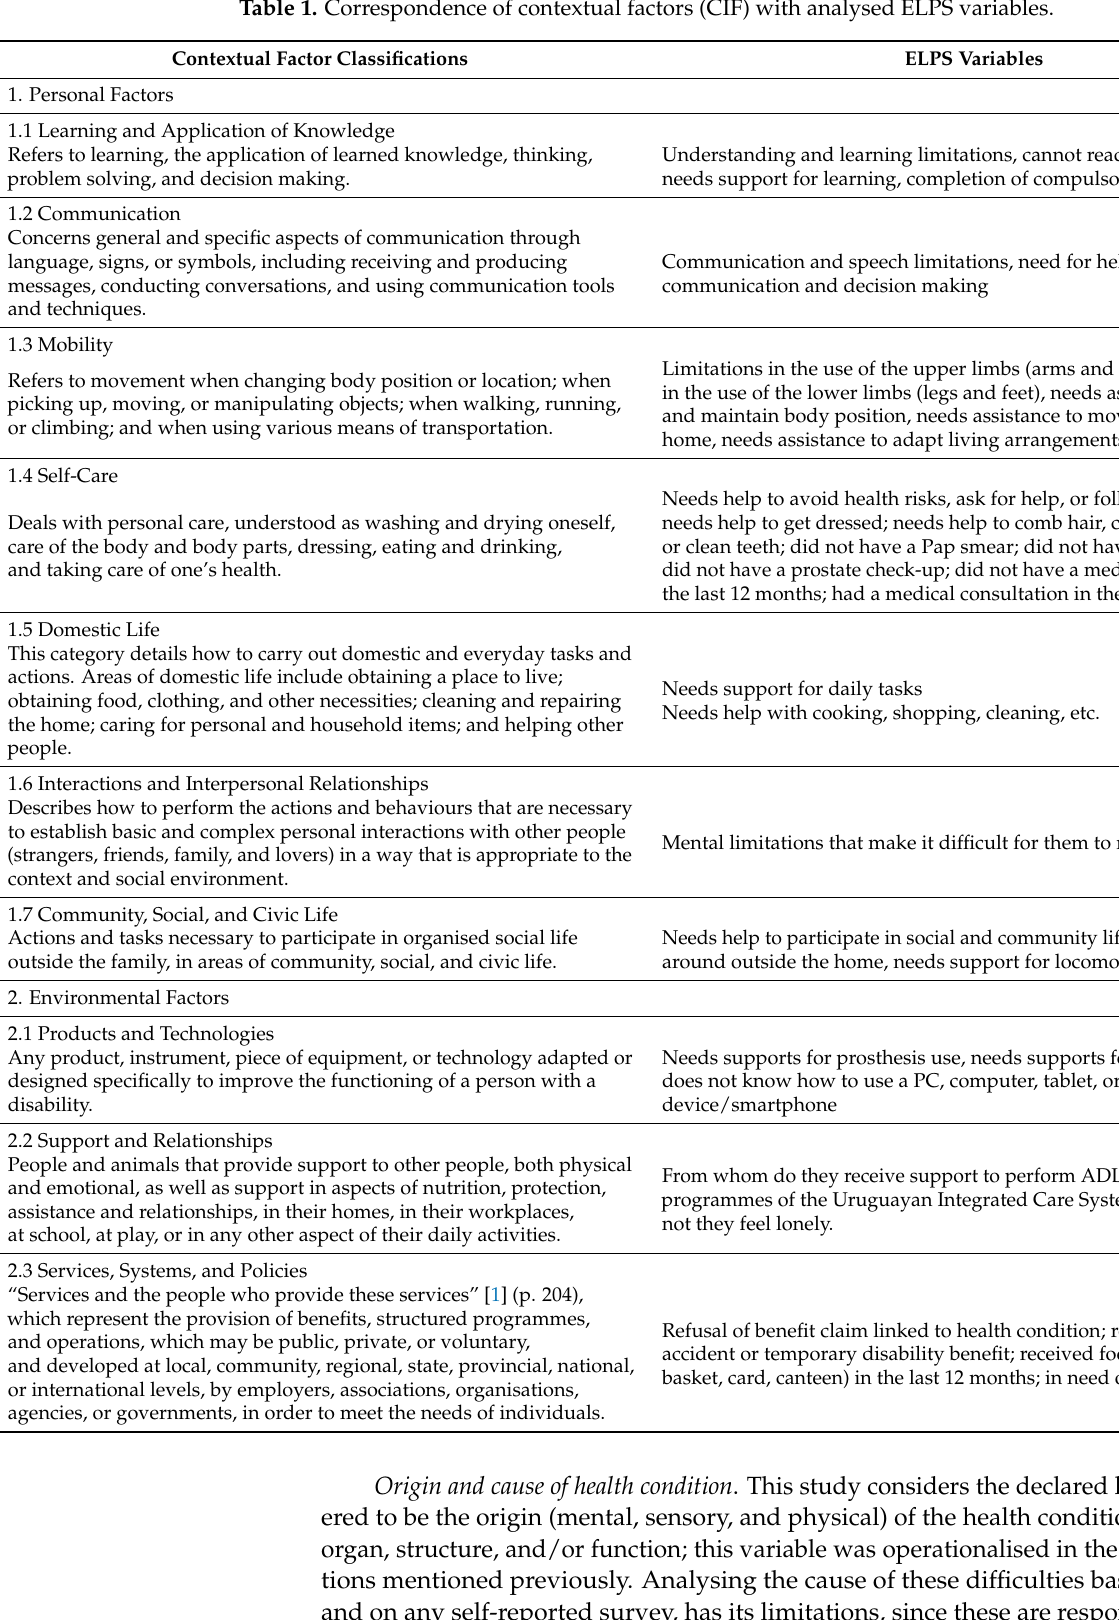
Table 1. Correspondence of contextual factors (CIF) with analysed ELPS